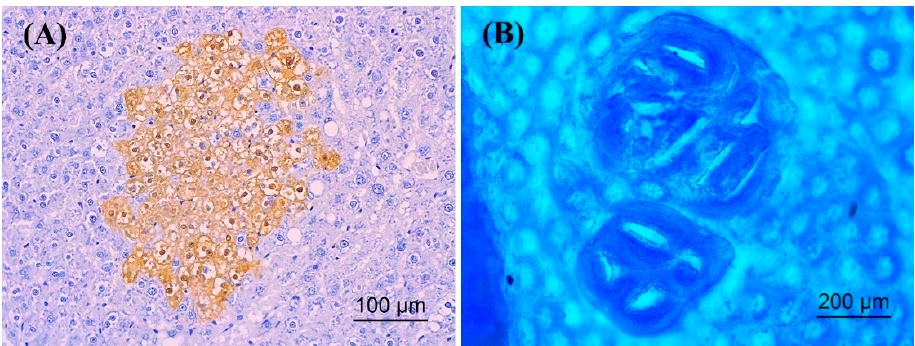
Figure 6. The preneoplastic lesions; ( A ) hepatic GST-P positive foci (20×), ( B ) colonic aberrant crypt foci